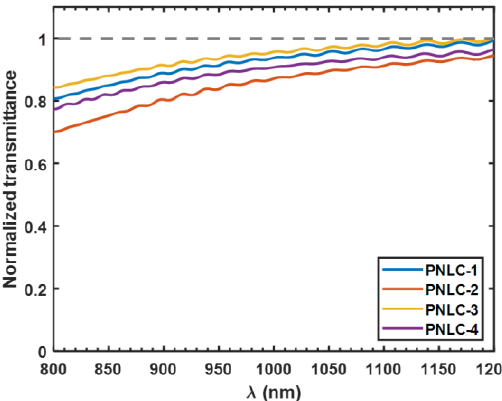
Figure 9. Normalized transmission spectra of PNLC 1–4 for an unpolarized light at 70 V.